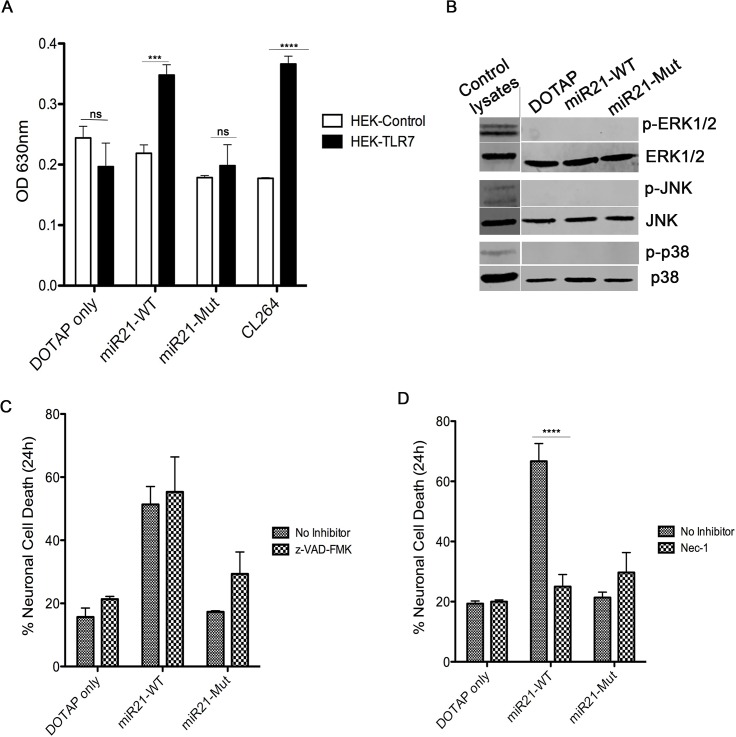
miR-21 neurotoxicity is rescued by Nec-1, a necroptosis inhibitor.
(A) HEK-Blue Null (HEK-control) or TLR7 overexpressing (HEK-TLR7) cells were incubated with 1 μg of synthetic miRNAs; miR21-WT, miR21-Mut, and CL264, a TLR7 ligand. Neurons were incubated for 24 hr followed by measurement of the secreted alkaline phosphatase (SEAP) enzyme activity (measured as absorbance at 630nm) as a read out of TLR7 activation. The results indicate a significant increase when TLR7 expressing cells were treated with miR21-WT, Let-7b and CL264; whereas, no difference was seen in DOTAP control and miR21-Mut. Statistical analyses were performed on data from three independent experiments. Error bars = SEM; *** P <0.001, **** P < 0.0001; two-way ANOVA with Bonferroni post-hoc test. (B) Wildtype (WT) mouse hippocampal neurons were incubated with 1 μg of synthetic miRNAs; miR-21 (miR21-WT) and miR-21 containing a mutation in TLR7 binding site (miR21-Mut) and DOTAP artificial EVs for 24 hr. Neurons were harvested and lysates were loaded for Western blotting to look at the activation of MAPK signaling proteins, p-ERK1/2, p-JNK and p-38. As the results indicate, no difference in expression of proteins was seen. Positive control lysates were used to check the specificity of the antibodies. (C) WT mouse hippocampal neurons were pre-treated for 1 hr with 10 μM z-VAD-fmk. After pre-treatment, neurons were treated simultaneously with 1 μg of synthetic miRNAs; miR-21 (miR21-WT), miR-21 containing a mutation in TLR7 binding site (miR21-Mut) and DOTAP artificial EVs. LDH assay indicate that z-VAD-fmk could not rescue the neurons from miR-21 induced cell death. (D) Similar to (C), neurons were pretreated for 1 hr with necroptosis inhibitor, Necrostatin-1 (Nec-1) and then incubated simultaneously with 1 μg of synthetic miRNAs; miR-21 (miR21-WT), miR-21 containing a mutation in TLR7 binding site (miR21-Mut) and DOTAP artificial EVs different artificial EVs. Results indicate that Nec-1 was able to protect neurons from undergoing cell death by miR-21 containing artificial EVs. Error bars = SEM; **** P < 0.0001; two-way ANOVA with Bonferroni post-hoc test.